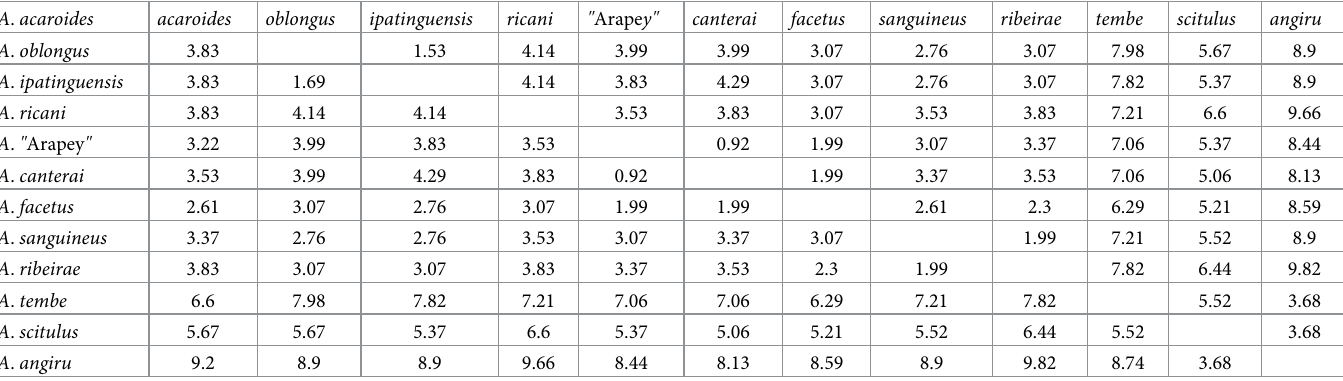
Table 20. Uncorrected p -distances in mt-coI between MOTUs of Australoheros